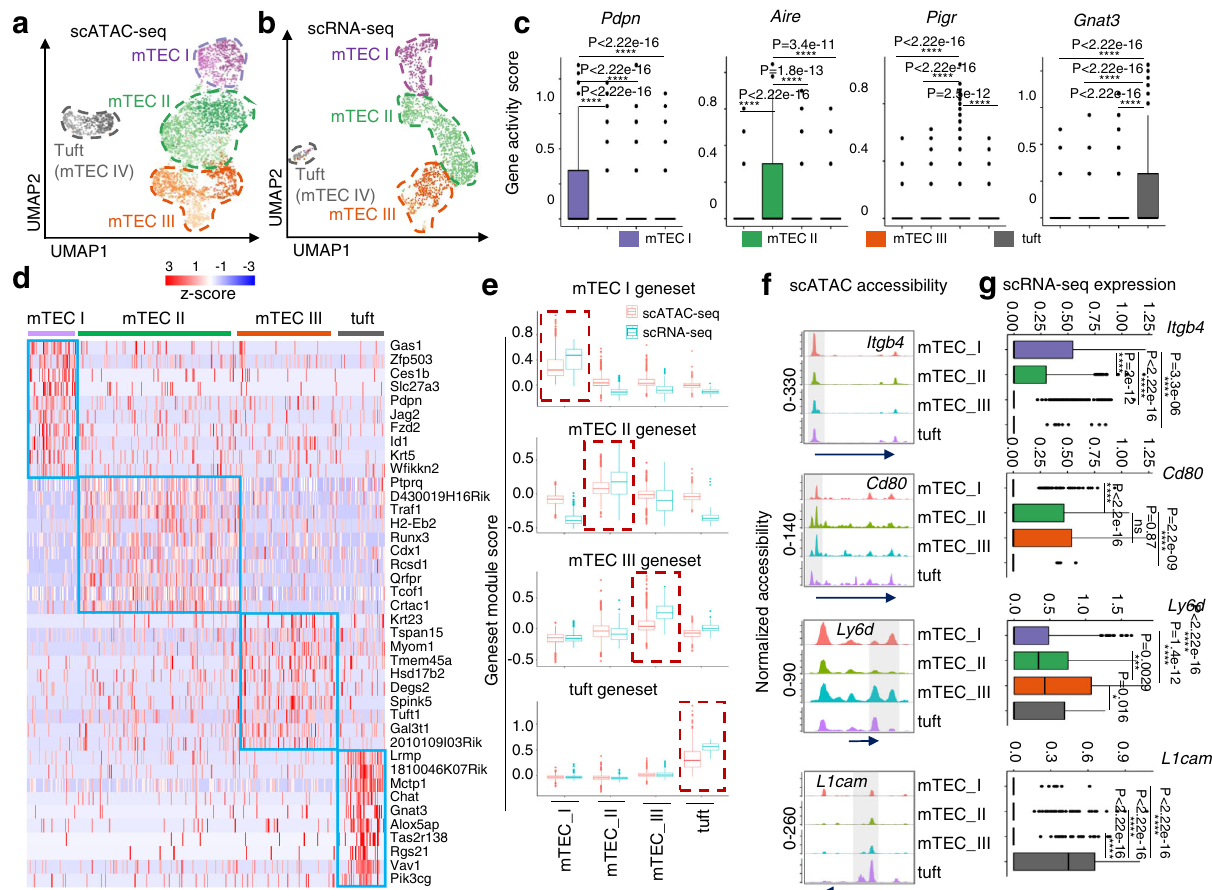
Fig. 1 Chromatin accessibility pro fi ling of mTECs was established according to the known single-cell transcriptional pro fi le. a UMAP visualization of scATAC-seq pro fi les of mTECs. Cell types are circled with dotted lines of different colors. b UMAP visualization of scRNA-seq pro fi les of mTECs. Cell types are circled with dotted lines of different colors. c Boxplots show marker genes for each mTEC cluster by gene accessibility matrix. Color represents speci fi c clusters of mTECs. mTEC I: n = 638, mTEC II: n = 1982, mTEC III: n = 1262, thymic tuft cells: n = 495. d Heatmap of the gene expression pro fi le of de fi ned mTEC populations in scATAC-seq was generated by the top ten marker genes from the gene activity matrix. The color scale indicates the level of gene activity. e Marker genes of each mTEC population calculated by scRNA-seq were added to both scRNA-seq and scATAC-seq. Gene set module scores in scRNA-seq (blue) and scATAC-seq (red) were compared with boxplots. f Genome tracks of aggregate scATAC-seq data show marker chromatin accessibility peaks. The arrow indicates the length and direction of the genes detected by scATAC-seq. g Boxplots show normalized expression of the marker genes for each mTEC cluster in scRNA-seq data. mTEC I: n = 364, mTEC II: n = 991, mTEC III: n = 458, thymic tuft cells: n = 62. The statistics was determined using Wilcoxon signed-rank test. **** p <